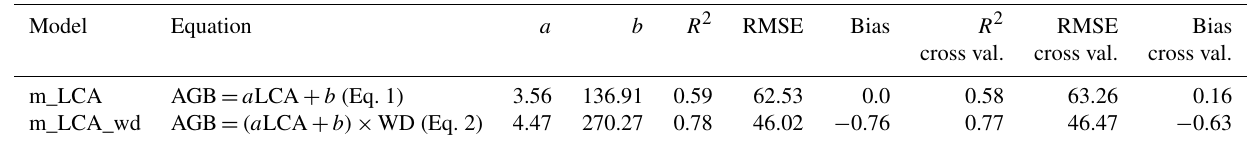
Figure 3. Distribution of R 2 between tree height thresholds used to determine LCA and AGB Local in the nine 1ha subareas (a) and distri- bution of R 2 between tree height thresholds and AGB inv in 1ha inventory plots of the four calibration sites (b) . All optimal thresholds are between 23 and 30m. The average maximal height threshold is 27m. Table 3. Coefficients R 2 , RMSE and bias for the models used to estimate AGB LCA without and with wood density (WD) as a weighting factor (m_LCA and m_LCA_wd, respectively). cross val. represents cross